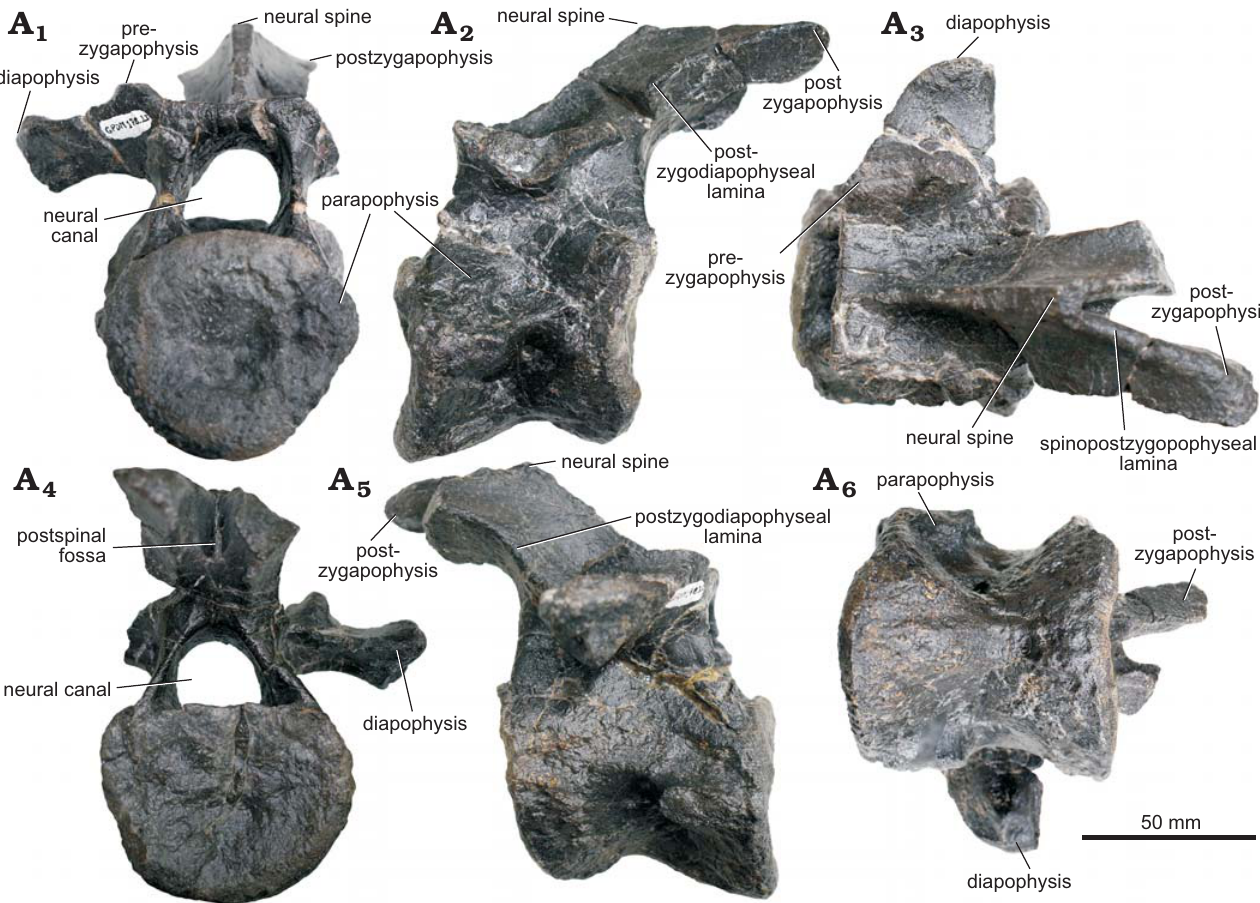
Fig. 12. Cervical vertebra of stegosaur GPDM 178, near Giffen, Cascade County, Montana; in anterior (A 1 ), left (A 2 ) and right (A 5 ) lateral, dorsal (A 3 ), posterior (A 4 ), and ventral (A 6 )